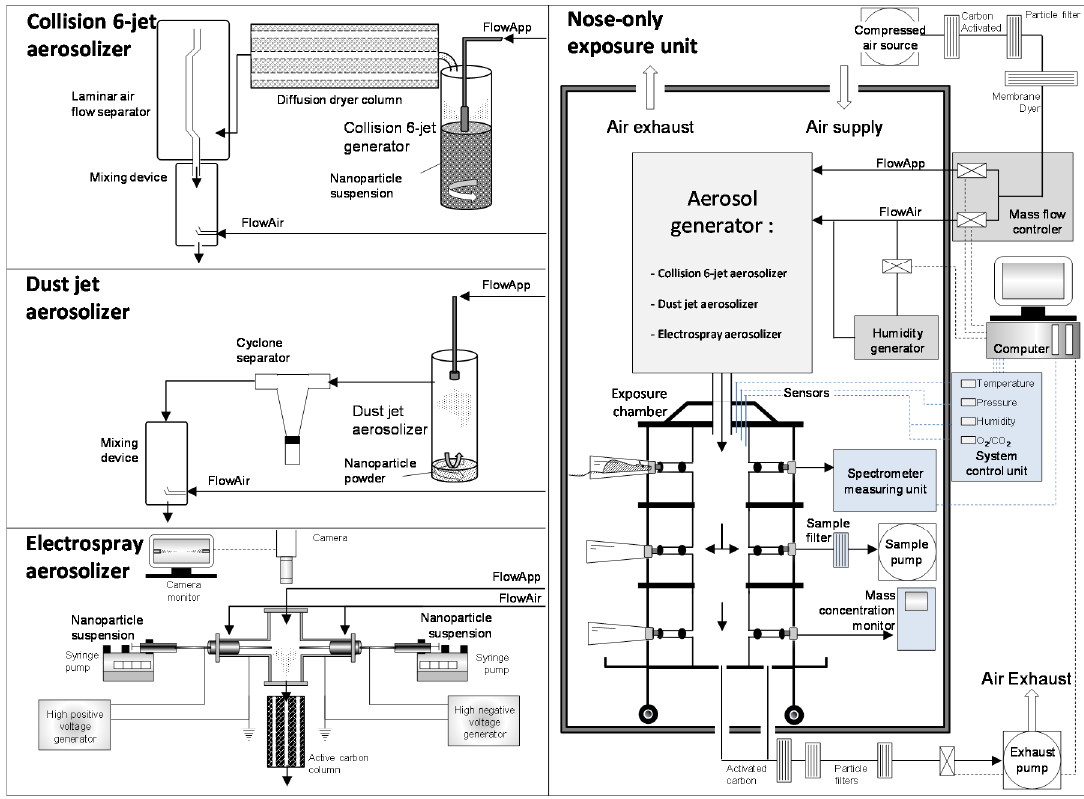
Figure 1. Experimental setup for aerosol generation and characterization.